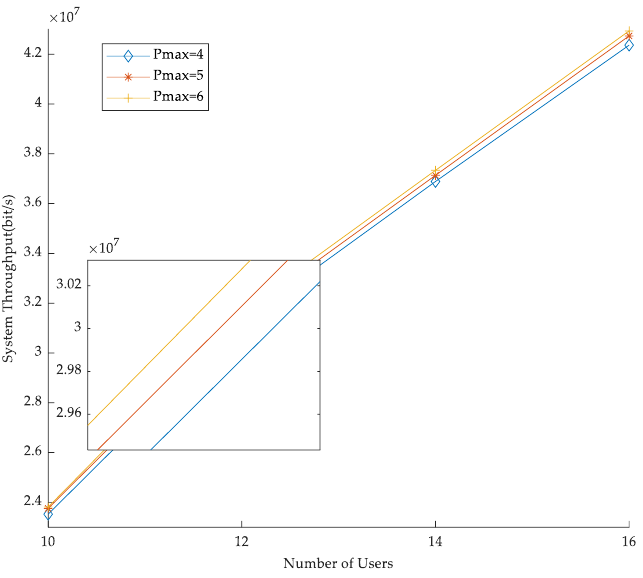
Figure 5. BS power versus throughput.